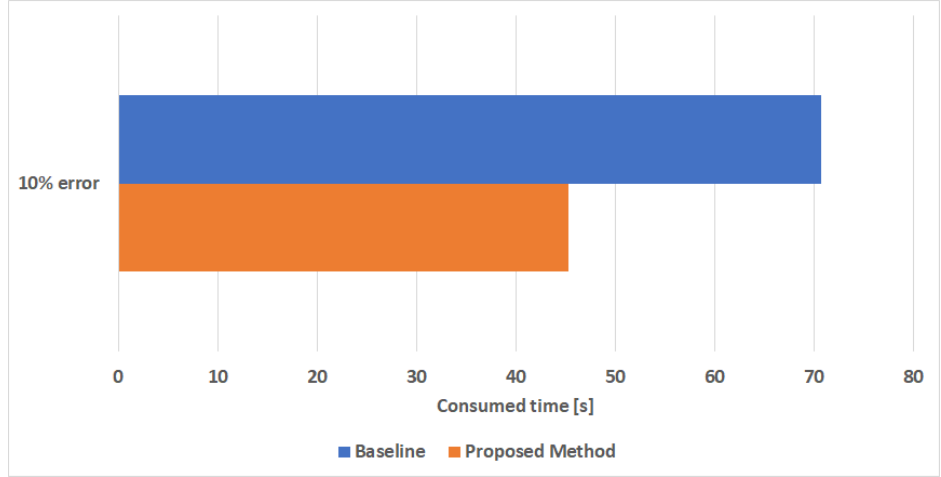
Figure 25. Load Testing—with 10% error.